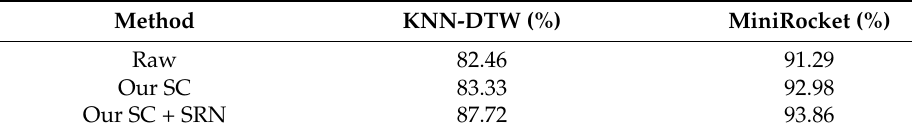
Table 4. The classification accuracy for different methods and networks with KTH-5.